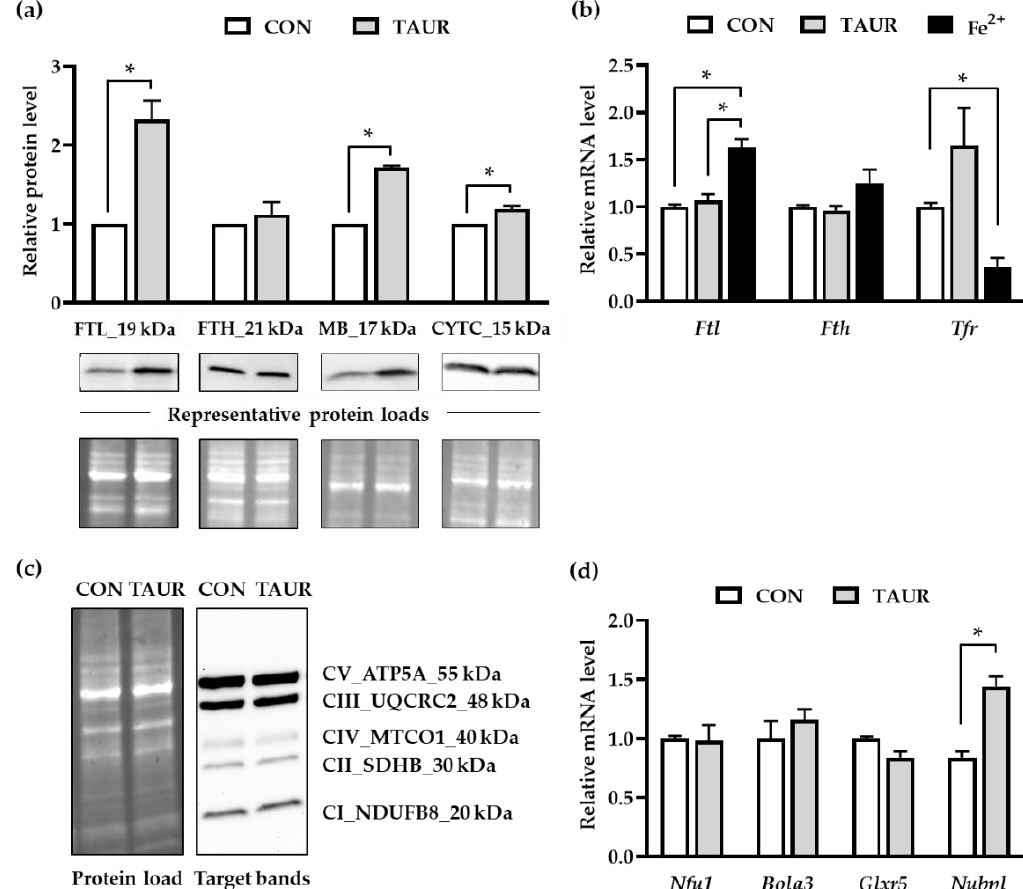
Figure 3. Taurine enhanced ferritin and myoglobin protein levels. ( a ) The mean protein levels of ferritin light chain (FTL), cytochrome c (CYTC) and myoglobin (MB) were increased after taurine (TAUR) supplementation. The levels in the untreated control (CON) were set to 1 for each individual experiment, and the results of TAUR supplementation are given relative to those of CON. Target band intensity was densitometrically analyzed and normalized by total protein load per lane, as visualized in a stain-free UV image. Representative pictures of the target bands (FTL, FTH, CYTC and MB) and the corresponding total protein bands are shown. ( b ) The mRNA levels of iron-sensitive genes Ftl, Fth and Tfr were quantified in response to treatment with TAUR and iron (II) sulfate (Fe 2+ ). Fe 2+ , which was used as a positive control, significantly enhanced Ftl and decreased Tfr mRNA levels compared to those of untreated cells. The mRNA levels of Fth were not affected by Fe 2+ or taurine. ( c ) A representative picture of target bands indicating the subunits of mitochondrial oxidative phosphorylation (OXPHOS) complexes CI (NADH dehydrogenese), CII (succinate dehydrogenase), CIII (ubiquinol-cytochrome c reductase), CIV (cytochrome c oxidase) and CV (ATP-Synthase) for CON and TAUR and the corresponding total protein load are shown. ( d ) The relative mRNA levels of NFU1 iron-sulfur cluster scaffold (Nfu1), BolA FAMILY MEMBER 3 (Bola3) and glutaredoxin 5 (Glxr5) were not affected, while nucleotide binding protein like (Nubpl) mRNA was upregulated in response to taurine supplementation. The data are shown as the means + SD (n = 3) for the protein analysis and means + SEM (n = 6) for mRNA results. * Indicates a significant difference; p < 0.05.